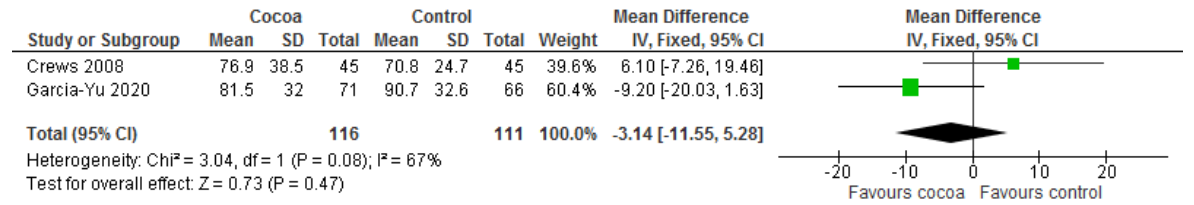
Figure 15. Forest plot of comparison: chocolate versus control, with the outcome—trail marking test (processing speed and cognitive flexibility) (seconds).